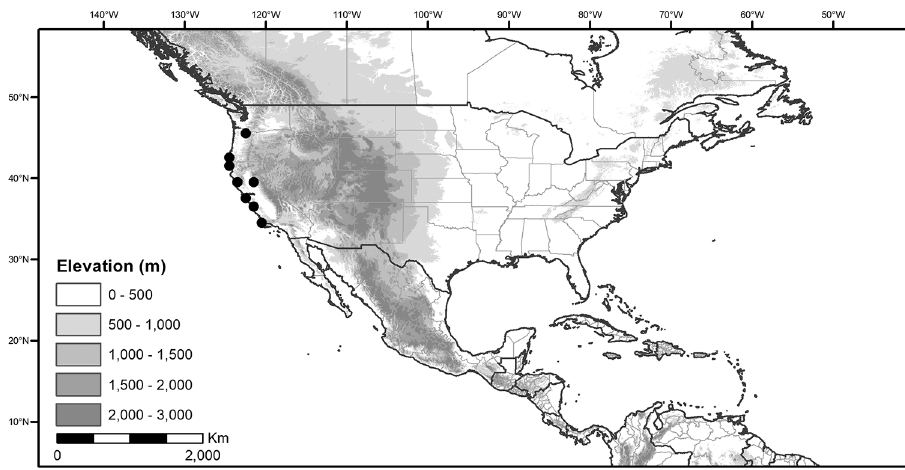
Figure 20. Distribution of Solanum furcatum